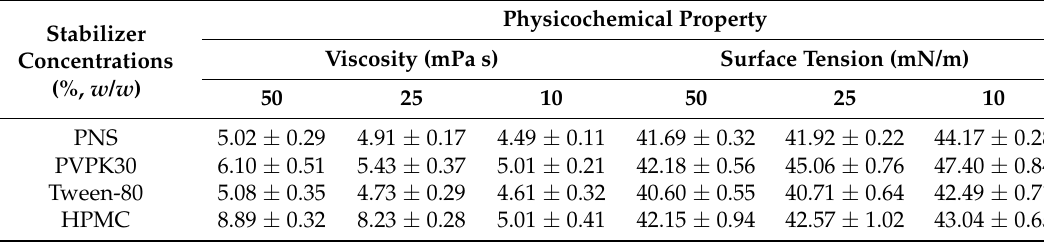
Figure 2. The schematic image of BCL-NS/PNS ( A ) and stabilization mechanism of BCL-NS/PNS ( B ). Table 2. Viscosity and surface tensions of the applied stabilizers (mean ± S.D., n = 3). Stabilizer